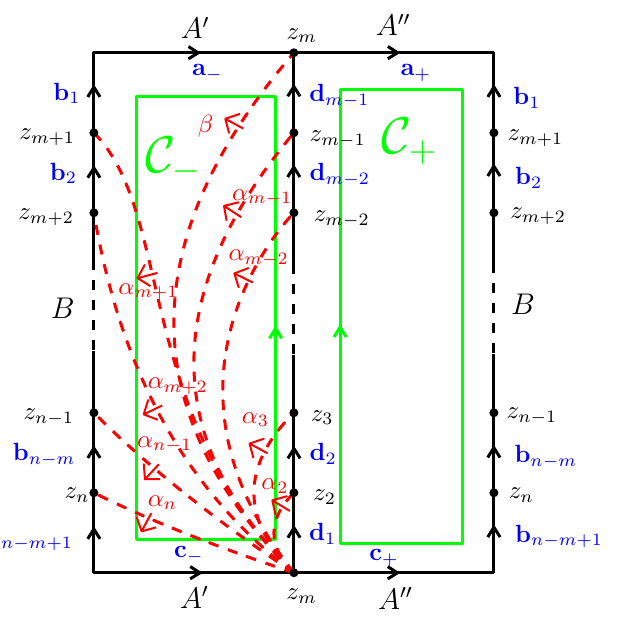
Figure 9. Integration chains a (cid:6) ; b j ; c (cid:6) ; d j and the local system L 1 de(cid:12)ned by the phases (cid:11) j and (cid:12) on a cylinder. Identifying a (cid:6) = c (cid:6) gives a